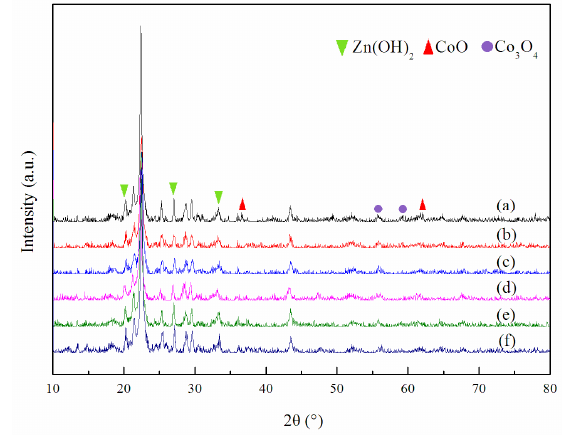
Figure 4. XRD patterns of Co ‐ Zn/H ‐ Beta catalysts. ( a ) Co ‐ Zn/H ‐ Beta ‐ F, ( b ) Co ‐ Zn/H ‐ Beta ‐ D, ( c ) Co ‐ Zn/H ‐ Beta ‐ R (H 2 + O 2 , 450 °C), ( d ) Co ‐ Zn/H ‐ Beta ‐ R (O 2 + H 2 , 450 °C), ( e ) Co ‐ Zn/H ‐ Beta ‐ R (O 2 + H 2 ,